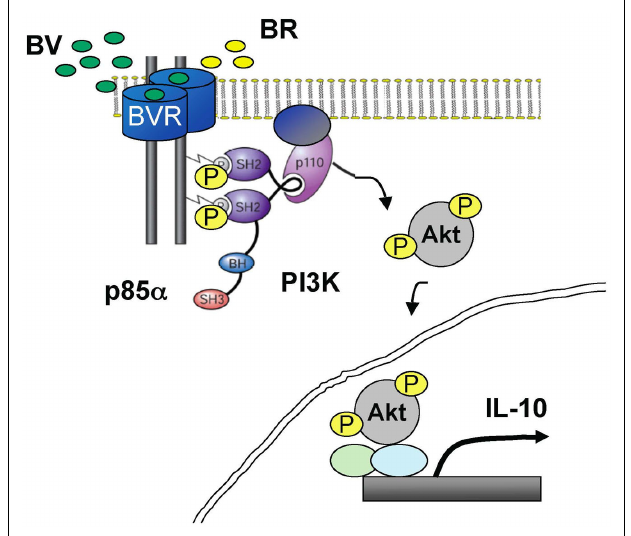
FIGURE 1 |A role of BV in activation of PI3K–Akt through cell surface BVR to elicit anti-inflammatory effects. BVR is expressed on the cell surface of macrophages and mediates the anti-inflammatory and cytoprotective signaling of BV. BV is converted to BR by BVR surf , which drives the recruitment and activation of PI3K–p85 α /p110 α to BVR to increase the IL-10